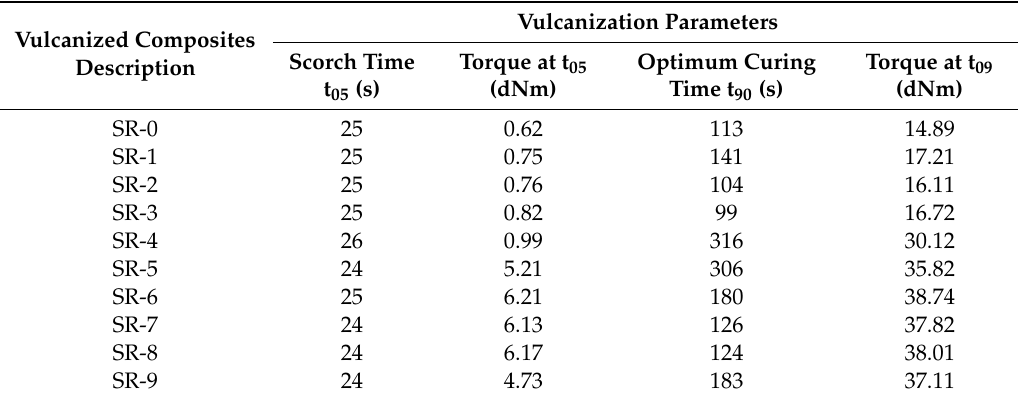
Table 3. Vulcanization parameters of the composite